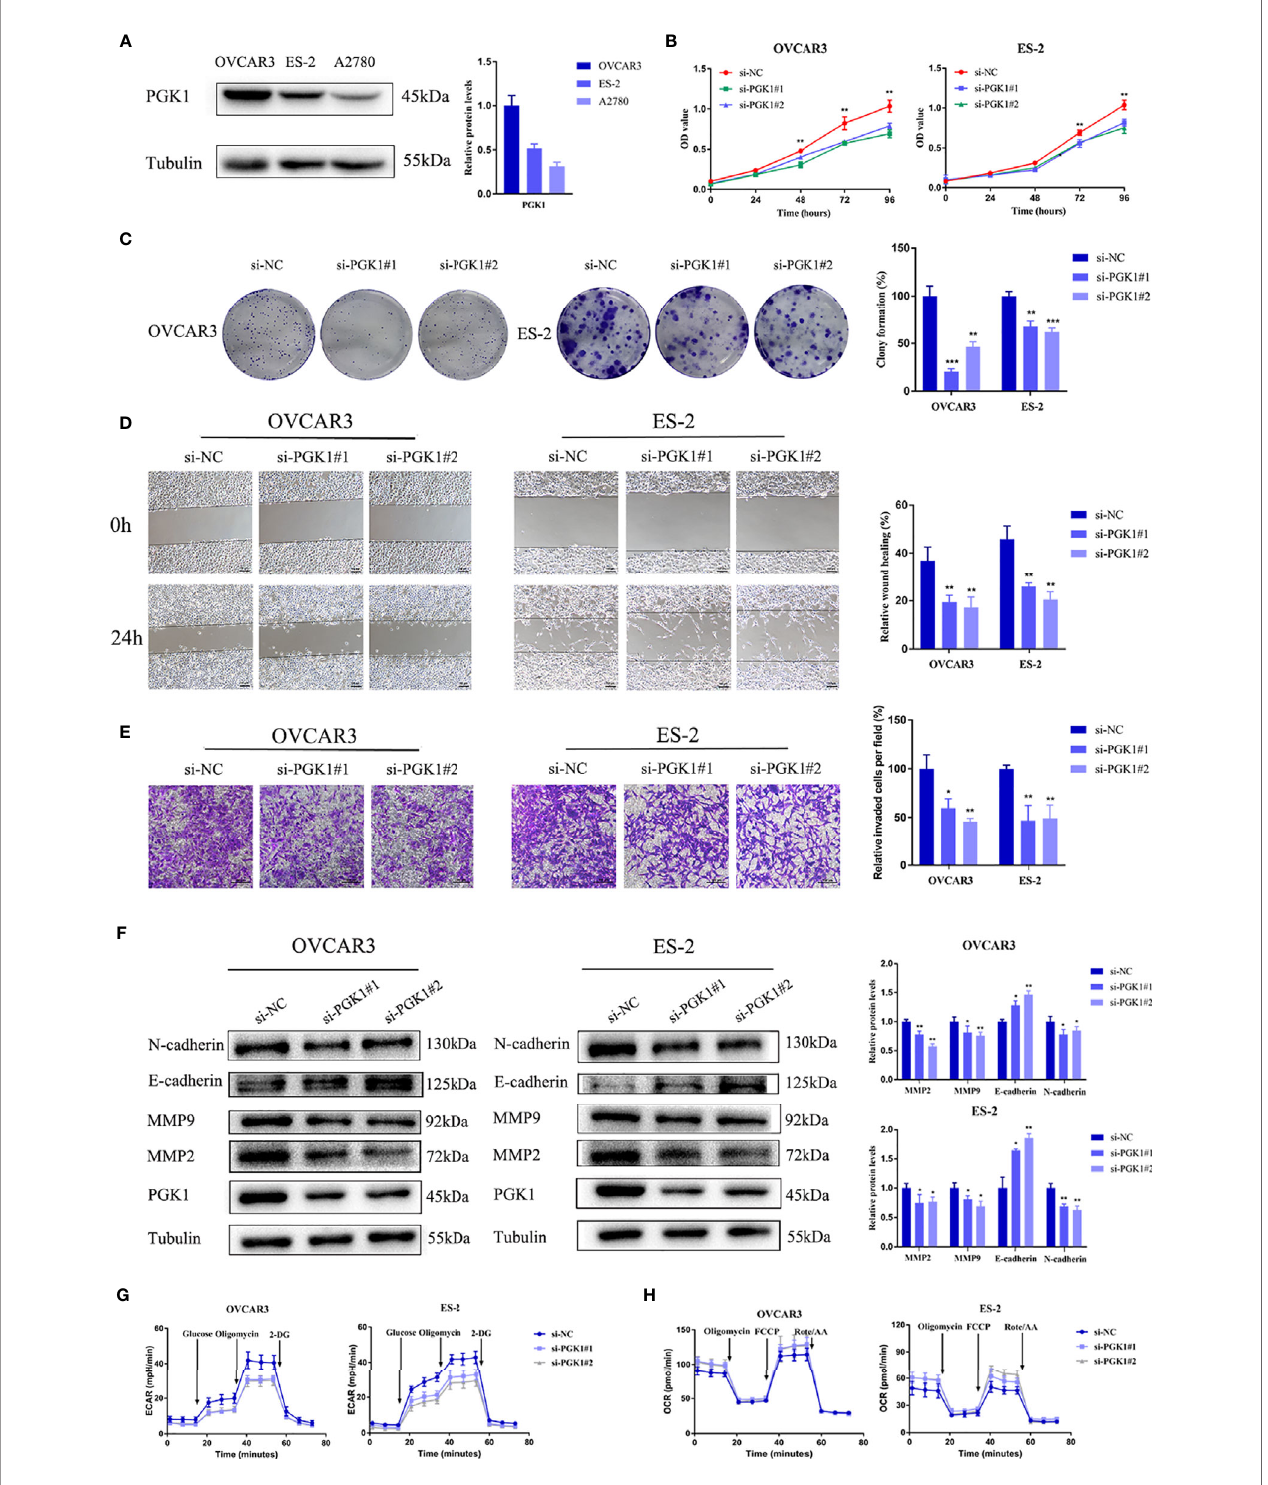
FIGURE 8 | PGK1 affected EMT process and glycolysis of ovarian cancer cells. (A) PGK1 protein expression in three kinds of ovarian cancer cell lines. (B) PGK1- siRNA inhibited the proliferation of ovarian cancer cells. (C) PGK1-siRNA reduced the formation of colonies of ovarian cancer cells. (D) PGK1-siRNA reduced the migration of ovarian cancer cells. (E) PGK1-siRNA reduced the invasion of ovarian cancer cells. (F) PGK1-siRNA decreased the protein expression levels of MMP2, MMP9, and N-cadherin but increased the protein expression level of E-cadherin. (G) Chart of ECAR measurement in PGK1-silenced cells. (H) Chart of OCR measurement in PGK1-silenced cells. Error bars represent the mean ± SD of three independent experiments. * P < 0.05; ** P < 0.01; *** P <